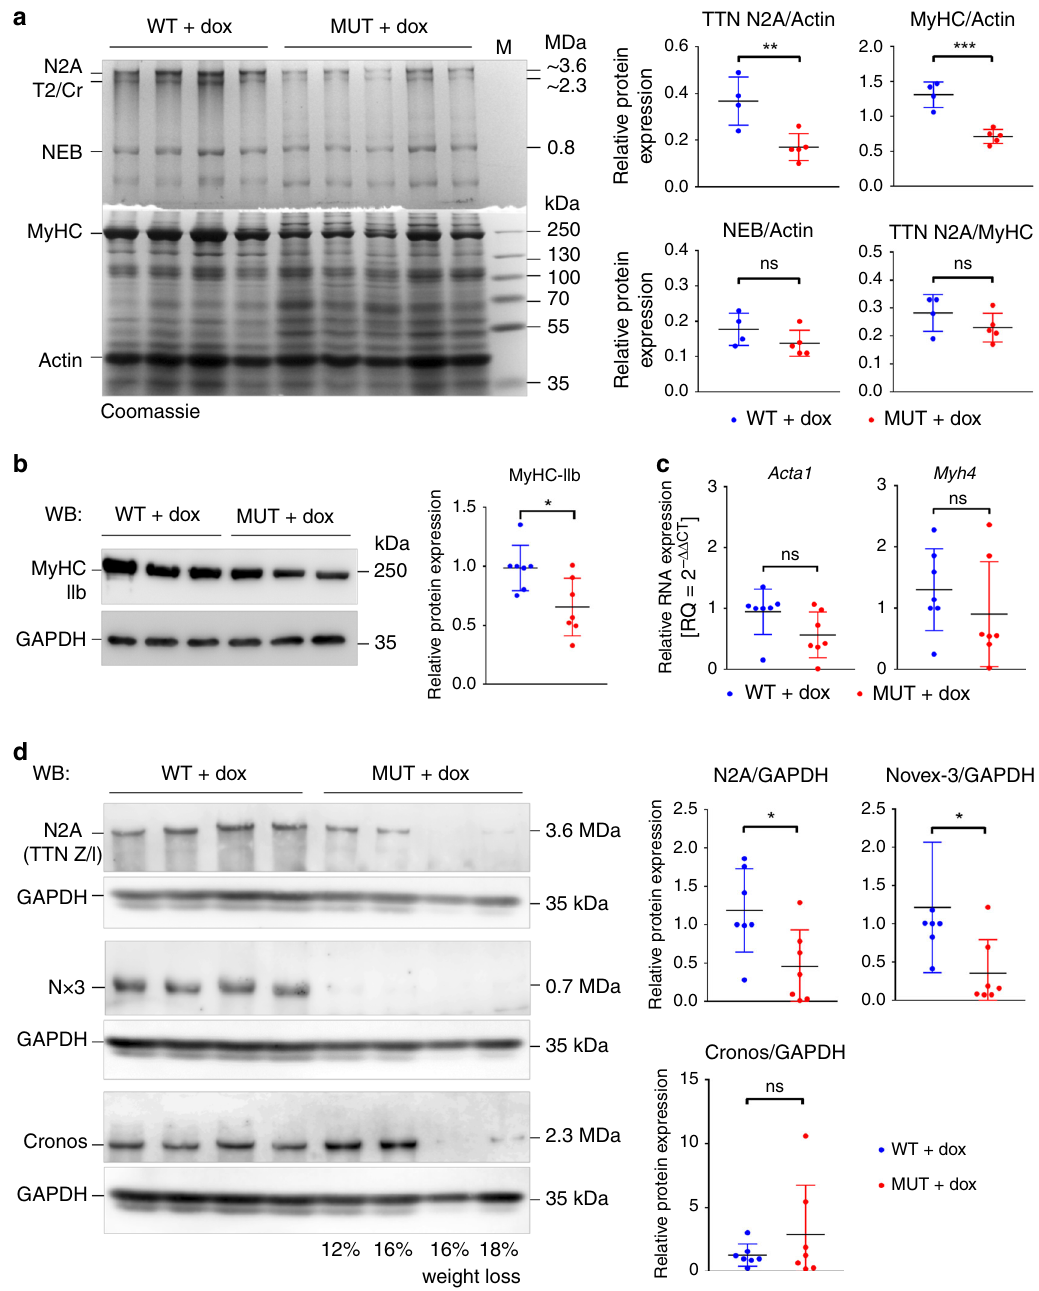
Fig. 5 Loss of Z-disc anchored TTN reduces myosin but not actin or Cronos. a Coomassie-stained titin gel (2.5% polyacrylamide) stacked onto a 10% running gel and loaded with protein lysates from dox-treated WT and MUT Ttn tm1c ;ACTA1-rtTA;tetO-cre pectoralis muscle. Right panels show results of densitometric quanti fi cation, comparing TTN (N2A), MyHC, or NEB expression to actin levels, as well as TTN (N2A) to MyHC levels, from WT ( n = 4) and MUT ( n = 5) mice. NEB, nebulin; MyHC, myosin heavy chain; T2, titin proteolytic fragment; Cr, Cronos isoform; M, marker. ** p = 0.0081; *** p = 0.0004; ns, non-signi fi cant. b Western blots detecting MyHC-IIb protein in MUT vs. WT gastrocnemius muscles. Right panel shows mean MyHC-IIb:GAPDH ratios in WT (blue) and MUT (red); n = 7 mice/group; * p = 0.0158. c Relative mRNA expression of alpha 1 skeletal muscle actin ( Acta1 ) and Myh4 (codes for MyHC-IIb) in gastrocnemius muscles measured by qPCR; n = 7 mice/group; ns, non-signi fi cant. N2A titin was probed by antibodies to TTN Z/I (2080). d Representative western blots showing expression of TTN isoforms in WT and MUT Ttn tm1c ;ACTA1-rtTA;tetO-cre pectoralis muscle. GAPDH served as loading control. Nx3, Novex-3 isoform. Right panels show results of densitometric quanti fi cation of western blots performed on WT and MUT gastrocnemius muscles, indexed to WT levels ( n = 7 mice/group); * p N2A = 0.0201; * p Novex-3 = 0.0239. All graphs show mean ± SD. All p -values were calculated using two-tailed unpaired Mann – Whitney U-test or two-tailed unpaired Student ’ s t-test. All data were obtained from ~30-day dox-treated muscles. Source data are provided as a Source Data fi